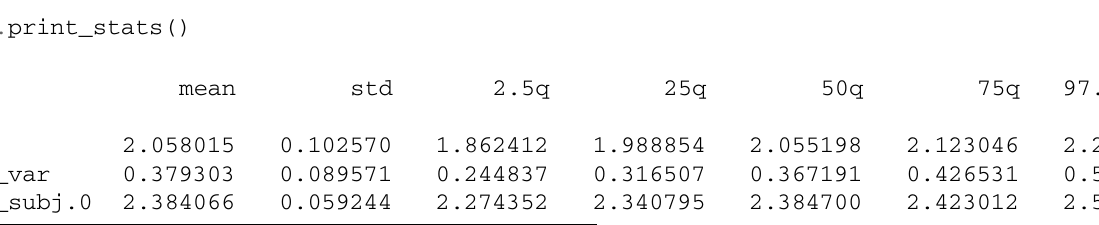
FIGURE 3 | Posterior plots for the group mean (left half) and group standard-deviation (right half) of the threshold parameter a . Posterior trace (upper left inlay), auto-correlation (lower